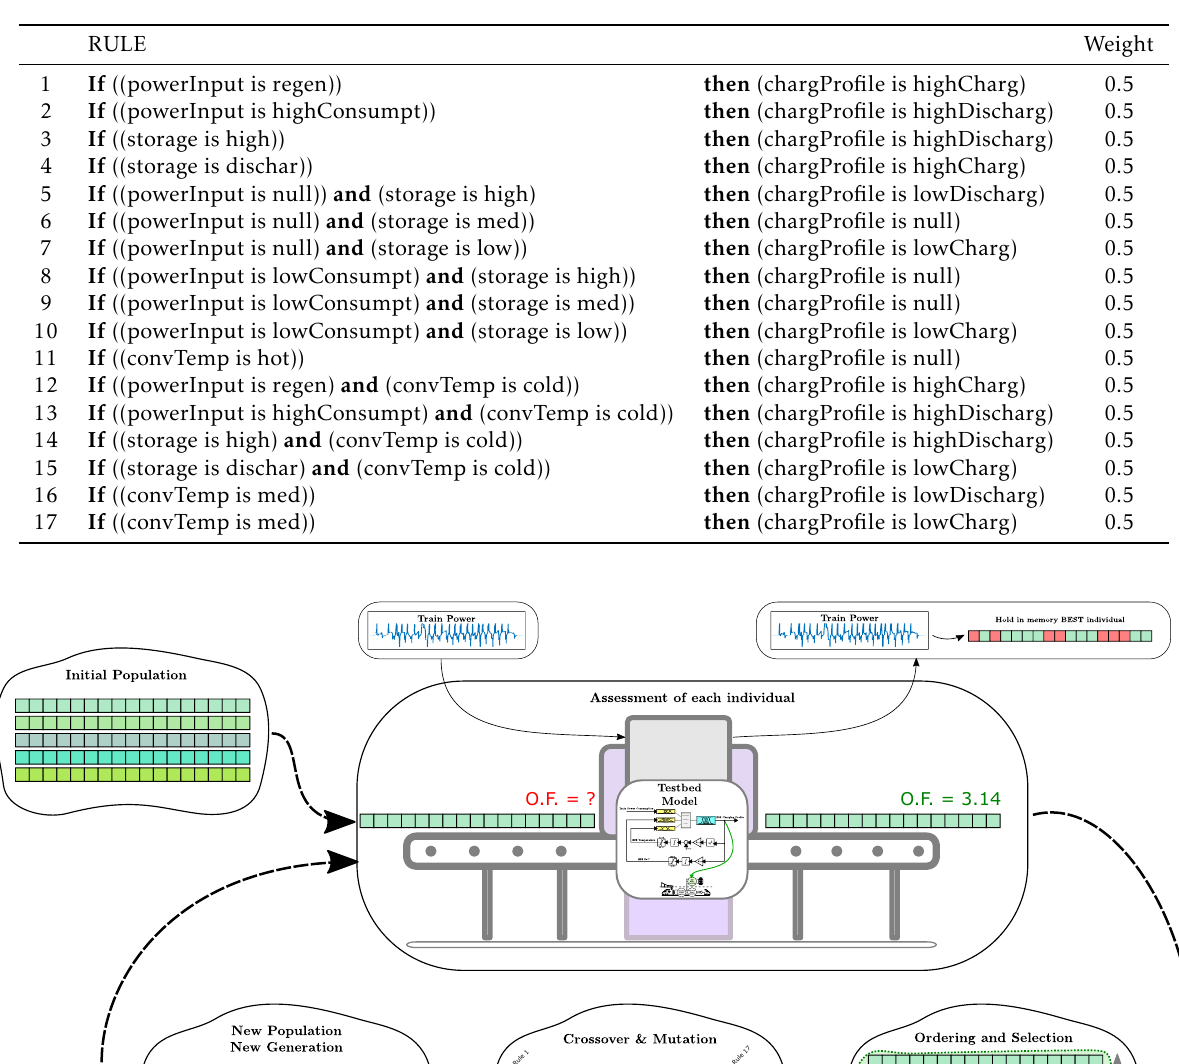
Table 1. List of fuzzy rules with the initial weights.